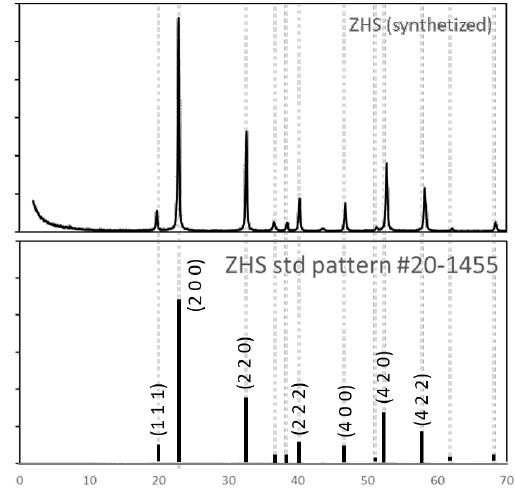
Figure 2 . X-ray diffractograms of ZHS synthesized, compared with standard pattern (ICDD/JCPDS, PDF no. 20-1455).